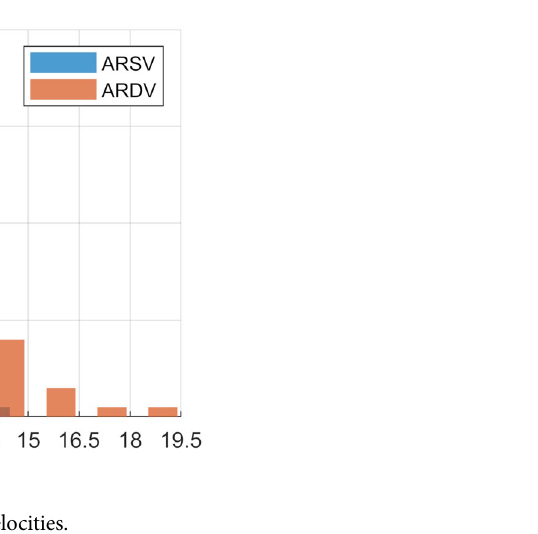
Figure 4. Distributions of the aortic root